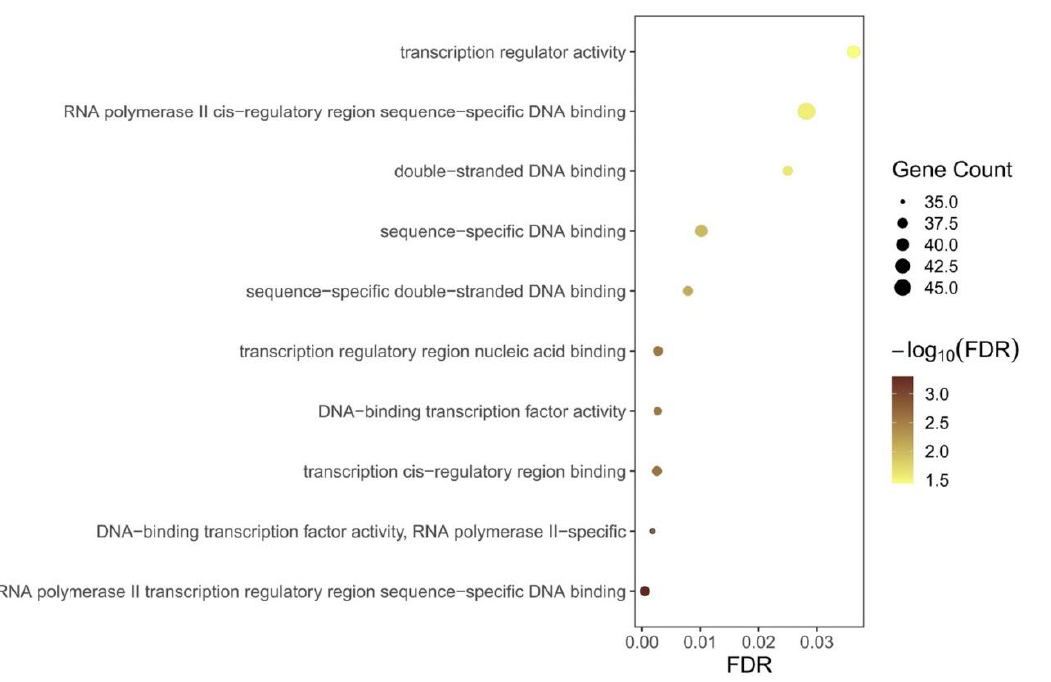
Figure 4. Gene ontology (GO) analysis of differentially expressed genes in the high-dosage intervention group compared with the control group. GO enrichment analysis of differentially expressed genes was retrieved using go:profiler website-based database. All the adjusted statistically significant values of these terms were labeled using negative 10-based log transformed with different colors.